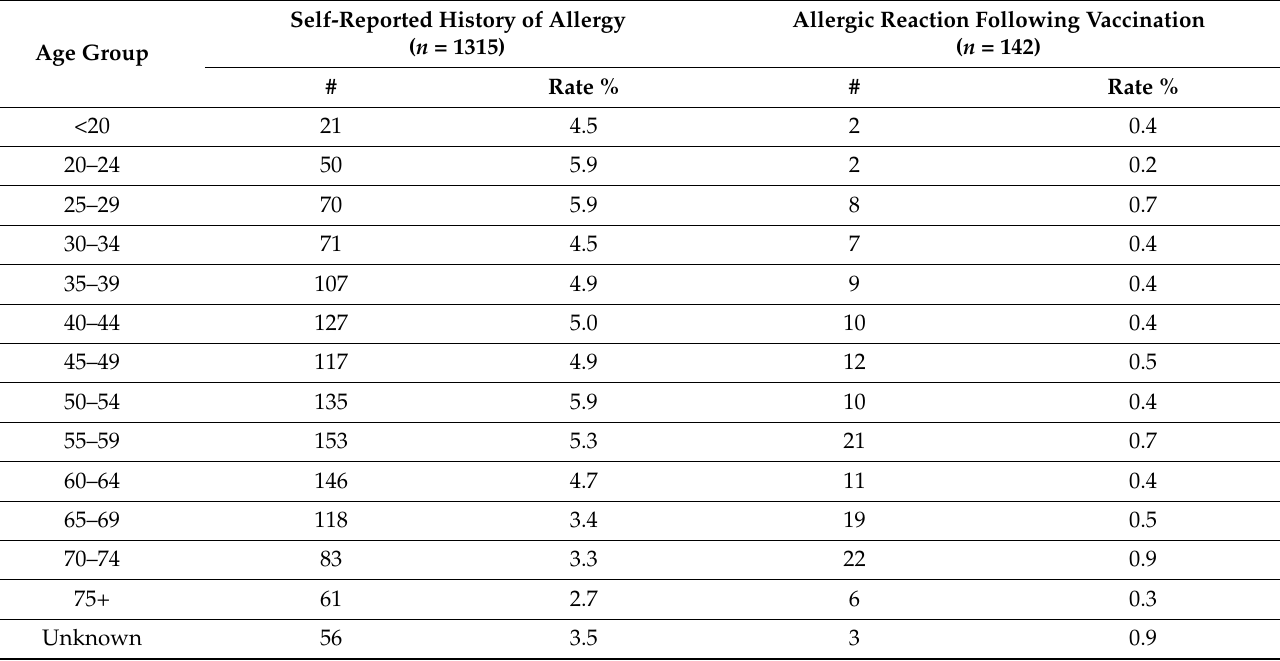
Table 3. Distribution of self-reported history of allergy and self-reported allergic reaction rates following vaccination by age